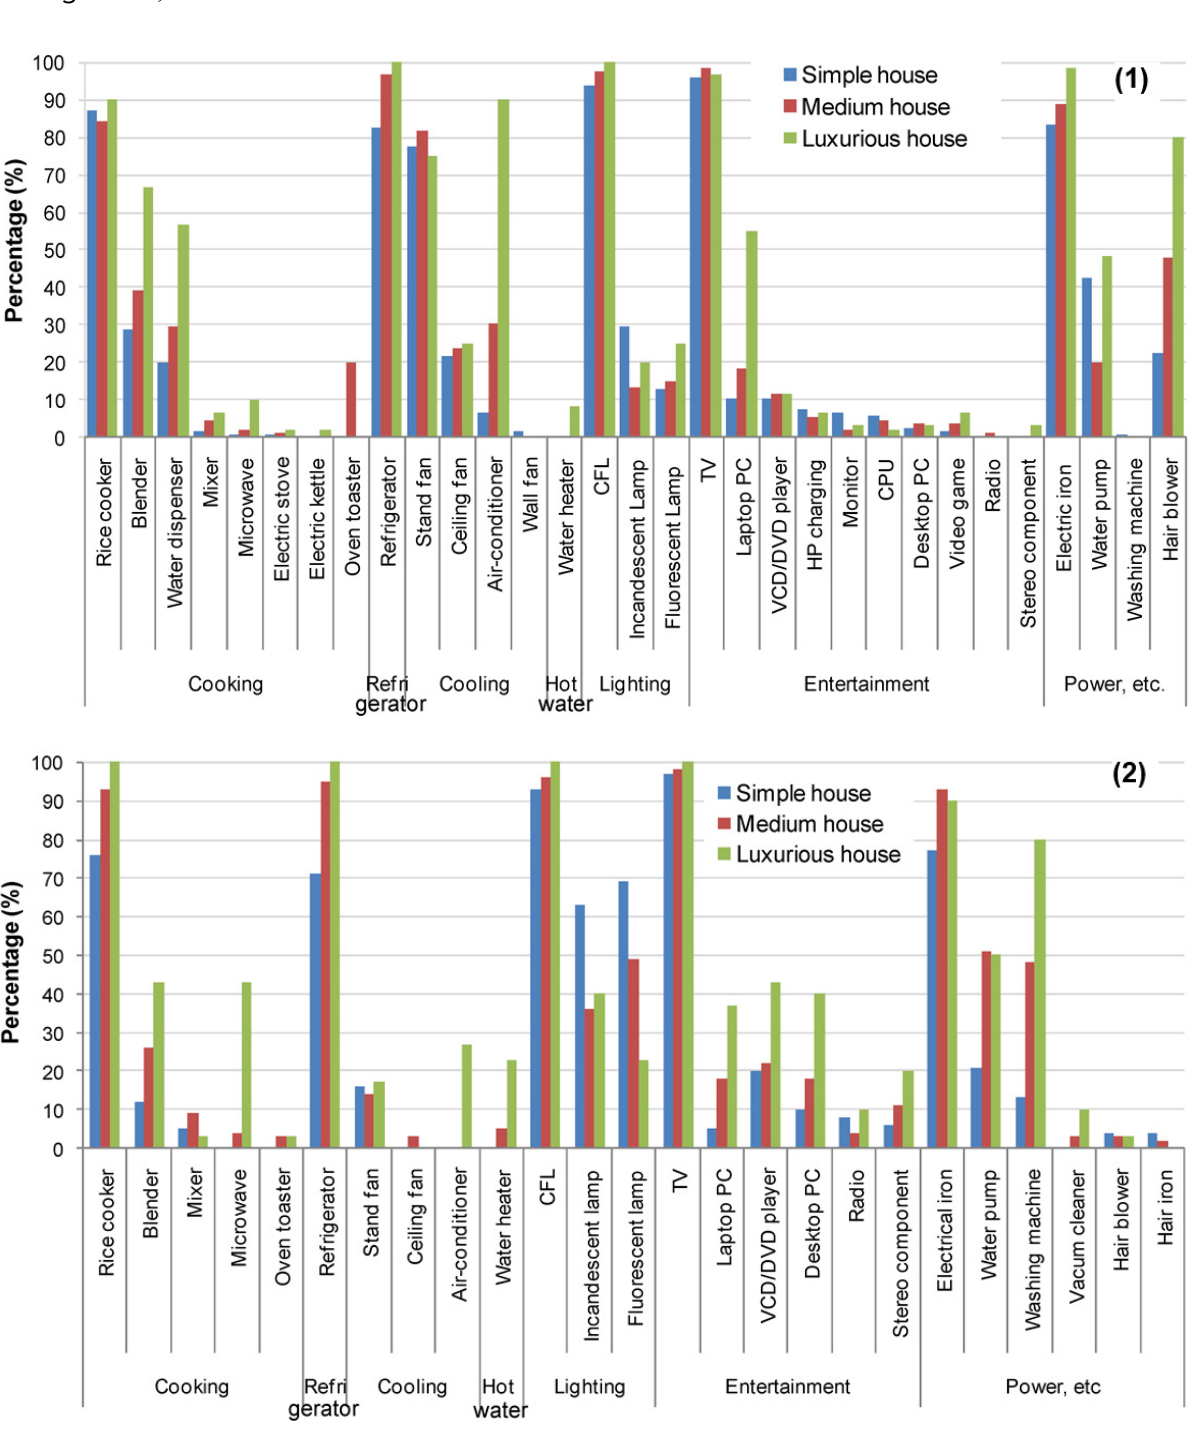
Figure 7. Ownership level of appliances in ( 1 ) Jakarta and ( 2 )